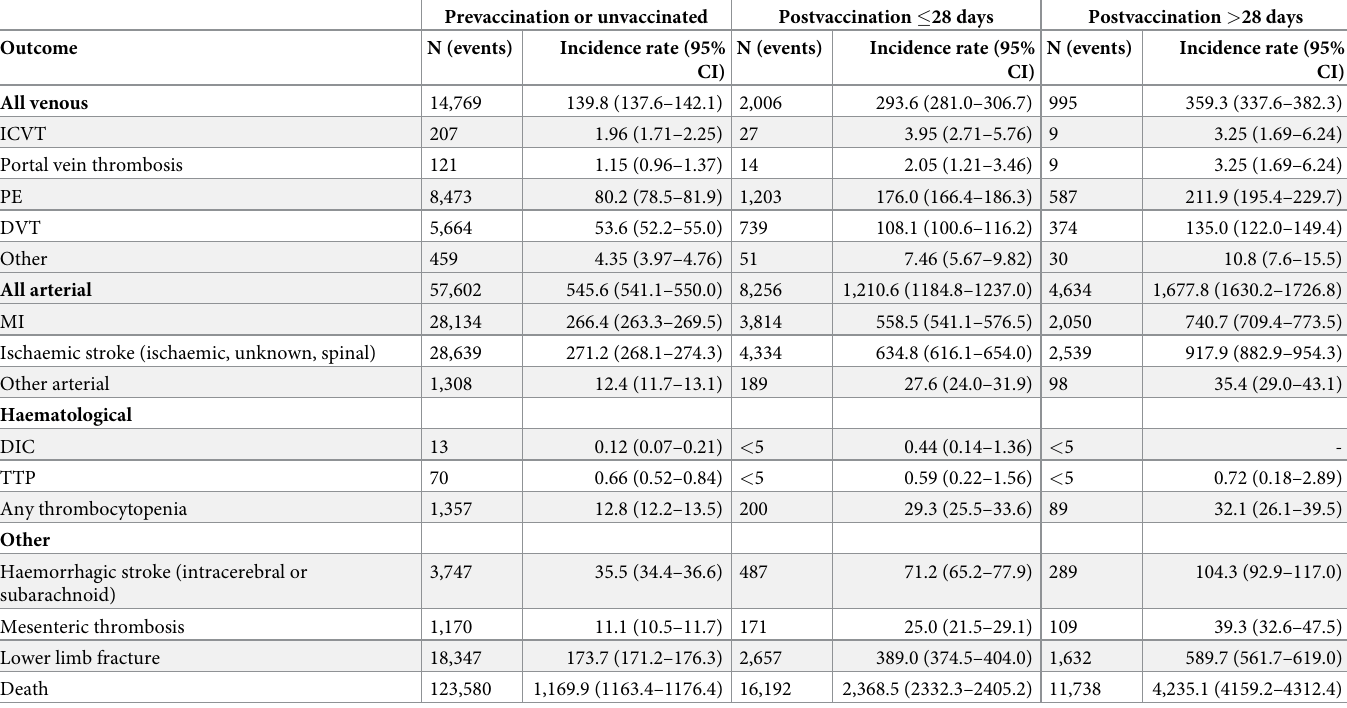
Table 2. Numbers and incidence rates pre- and post-first ChAdOx1-S. Incidence rate per 100,000 person years. Disclosure control prevents presentation of n >